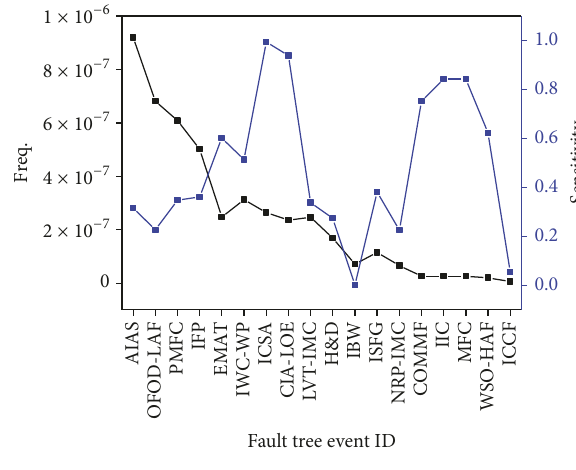
Figure 16: Sensitivity versus frequency for fatality data.